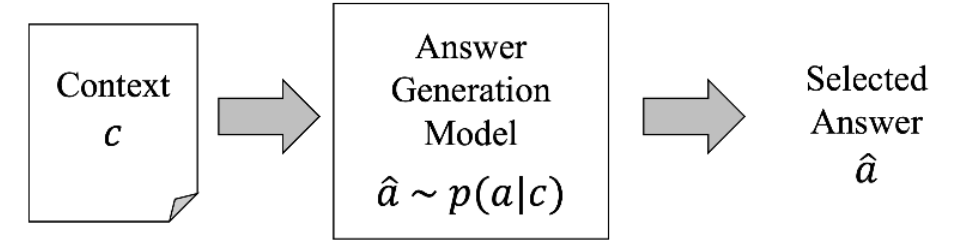
Figure 4. The input and the output of the Answer Generation Model.